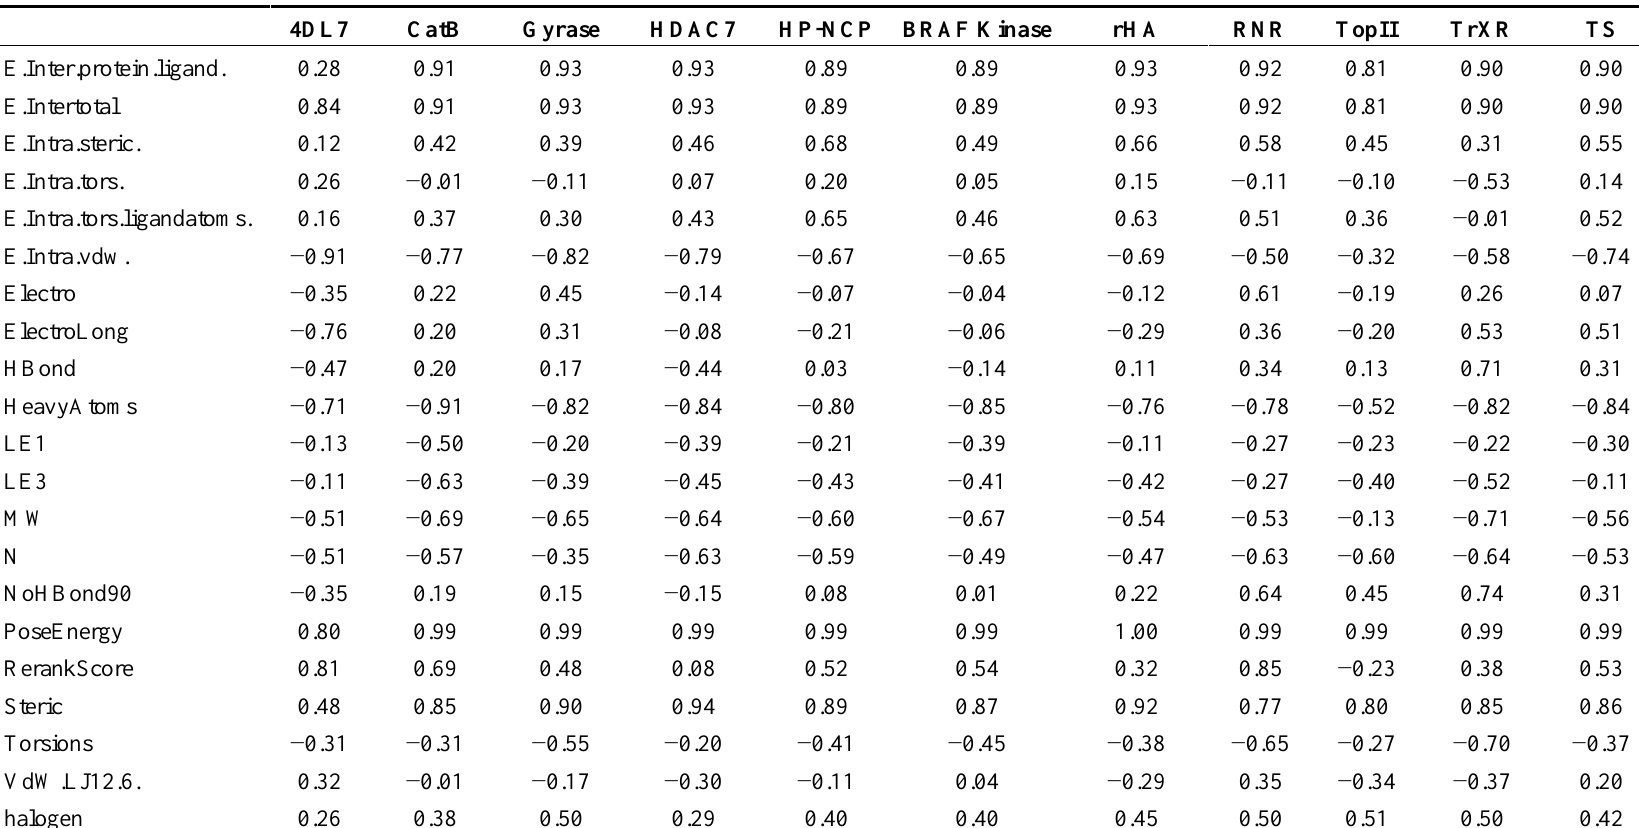
Table 8. The correlation of the factors that determine the biding interaction of the metallocompounds with the receptors using Molgro docking (unconstrained docking). 4DL7 CatB Gyrase E.Inter.protein.ligand.